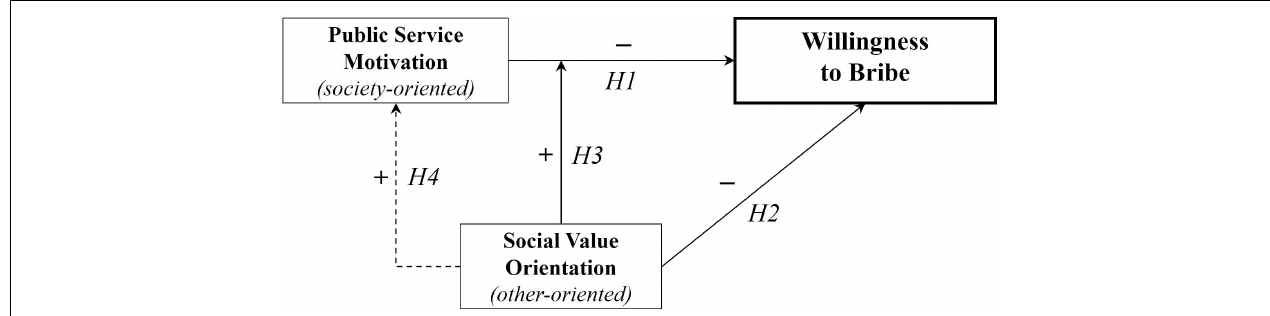
FIGURE 1 | Conceptual